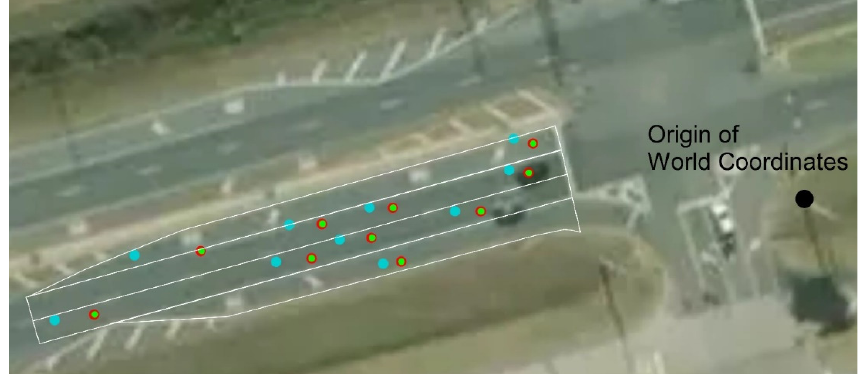
Figure 9 . Vehicle locations in the world coordinates after coordinate transformation . Figure 9. Vehicle locations in the world coordinates after coordinate